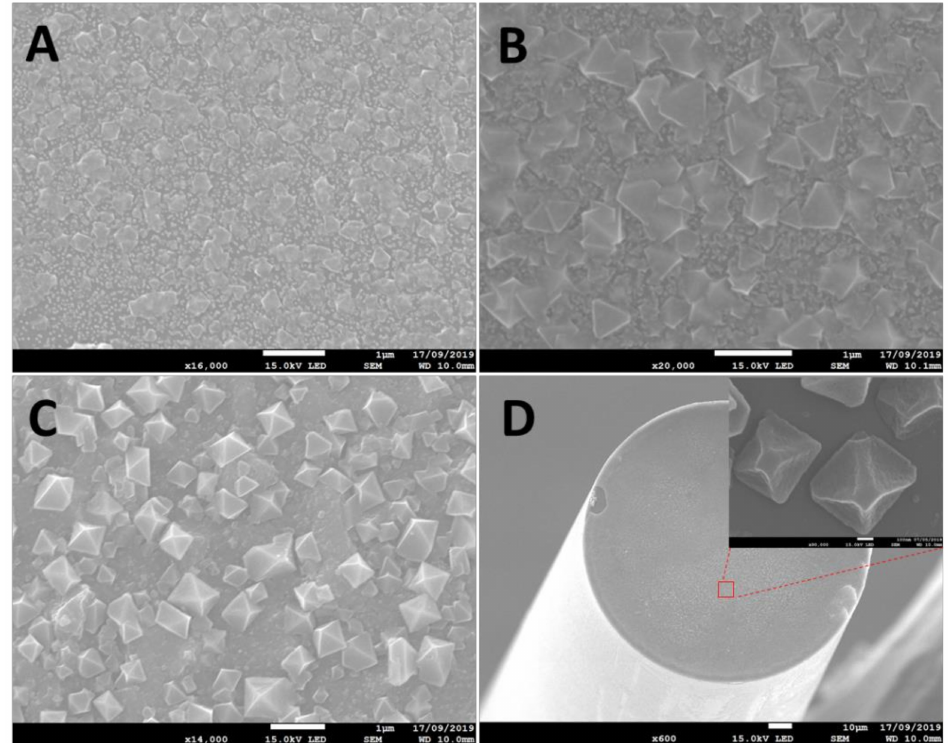
Figure 5. SEM images of HKUST-1 films: ( A ) 40-cycle-coated film (scale bar: 1 µ m), ( B ) 80-cycle-coated film (scale bar: 1 µ m), ( C ) 120-cycle-coated film (scale bar: 1 µ m), ( D ) optical fibre tip coated with a film with 120 coating cycles (scale bar: 10 µ m and 100 nm (inset